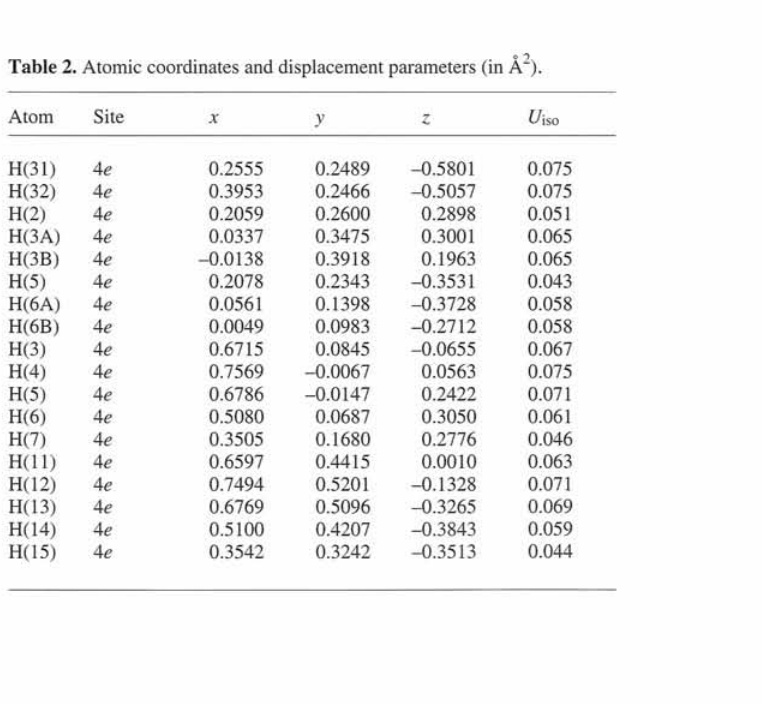
Table 1. Data collection and handling.